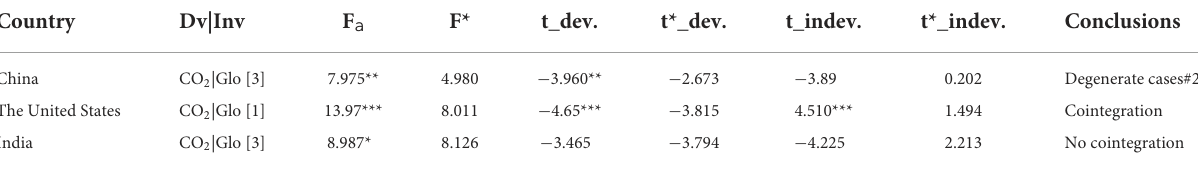
TABLE 4 Cointegration between variables.